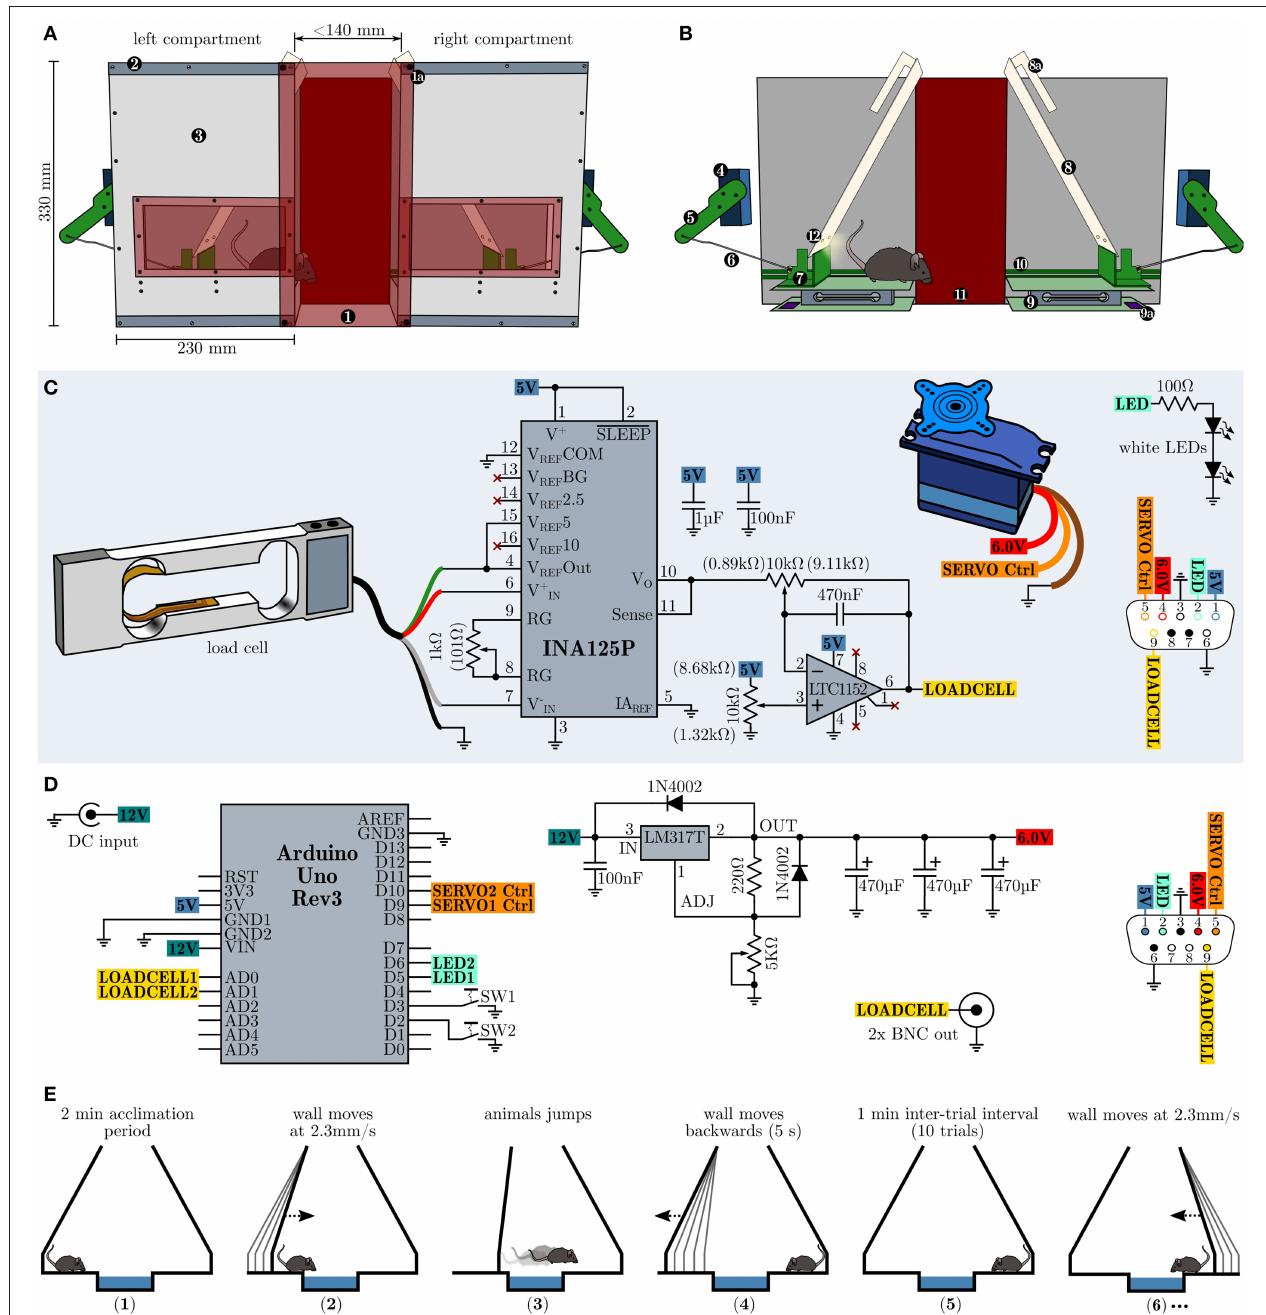
FIGURE 1 | Design, schematics and operational procedure of the moving wall box (MWB). (A) Overview of the MWB. (1) Red transparent front cover which is equipped with four strong neodymium magnets at its corners (1a) and allows to adjust the distance between the left and the right compartment via metal bands (2). The front cover of the compartments (3) is equipped with a red transparent window, allowing to observe the animal at all times. (B) Inner workings of the MWB. Servo motor (4); articulated joint, consisting of an arm (5) and a rod (6); sliding carriage (7) supporting the moving wall (8), which itself is equipped with slotted mounts (8a); balance (9), consisting of two opposite plates and the load cell signal conditioning circuit (9a); rails (10) for the sliding carriage; red transparent back cover (11); two white LEDs per wall (12). (C) Schematic depiction of the circuitry of one compartment. Potentiometer settings which gave best results are given in brackets. (D) MWB controller circuity. (E) Schematic representation of the MWB task procedure. (1) acclimatization for 2 min; (2) the wall of the compartment in which the mouse resides starts to move with constant speed of 2.3 mm/s, maximal for 60s (138 mm); (3) the wall stops to move once the animal has shuttled to the opposite compartment; (4 and 5) during a 1min inter-trial interval the first wall move quickly back to its default position; (6) subsequently the wall of the compartment in which the mouse resides starts to move and the second trial has started. This cycle is repeated 10 × per session.